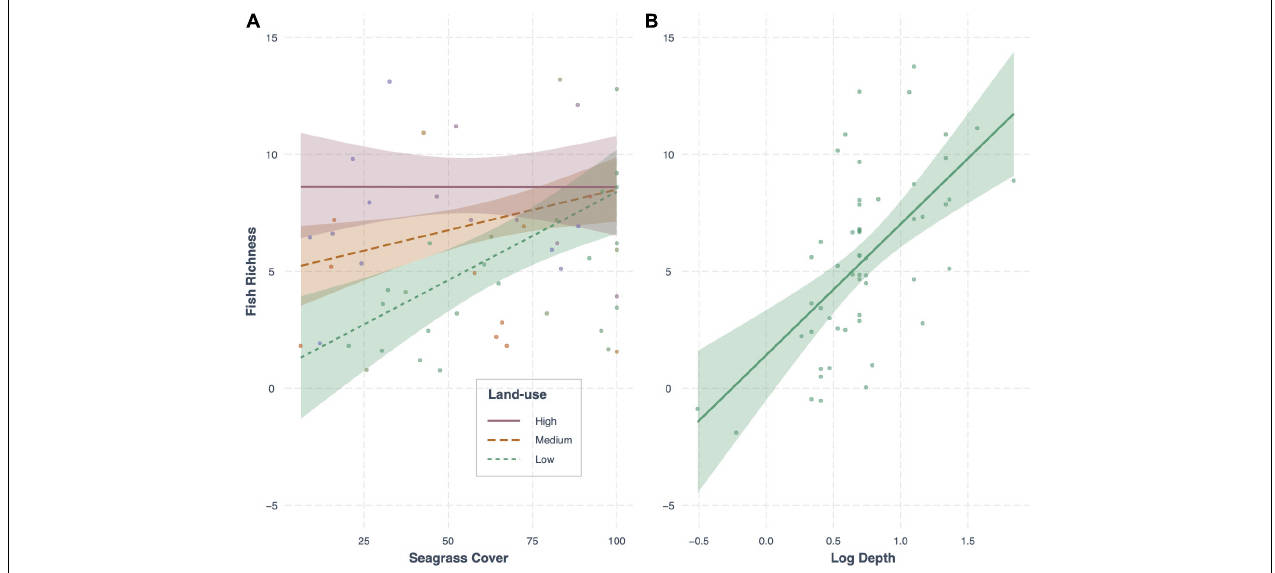
FIGURE 4 | Conditional effect plots for the model best predicting fish richness (R 2 = 0.47) in tropical seagrass meadows across 12 sites. Predictor variables include (A) the interaction between land-use (low, medium, high) and seagrass cover (%), and (B) log depth (m). Shaded areas represent 95% confidence intervals, reflecting the variance of the fixed effects.